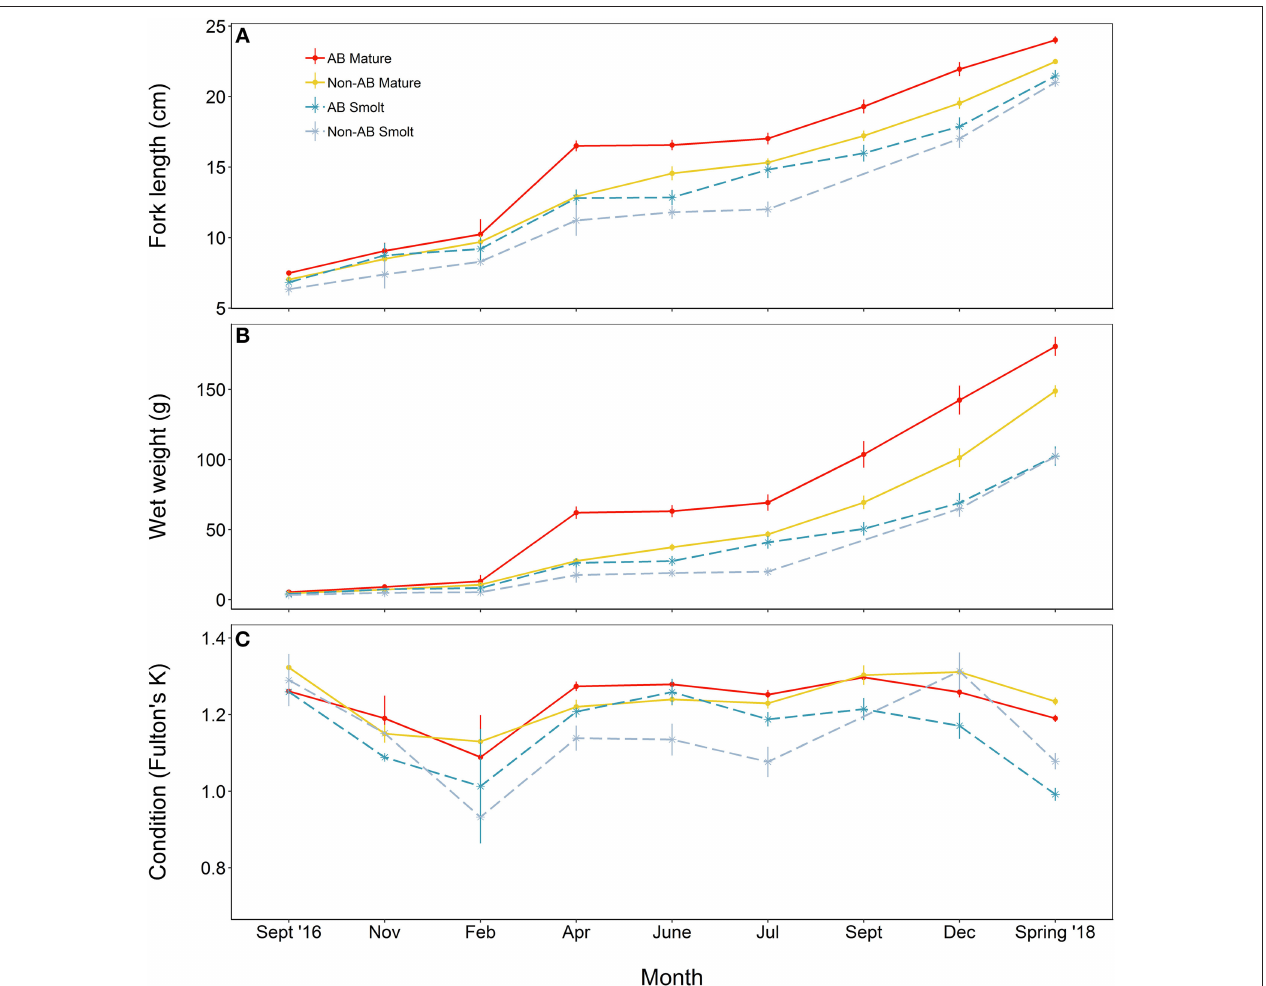
FIGURE 3 | Trajectories of (A) length, (B) mass, and (C) condition factor ( K ) of brown trout offspring (derived from wild-caught parents from two populations) that were classed as either smolt (migratory tactic) or freshwater maturing (non-migratory/resident) tactic. AB, anadromous-background population; non-AB, non-anadromous-background population. Mean values (with associated standard errors) are shown for measurements taken at key time points over the course of 2 years of tank